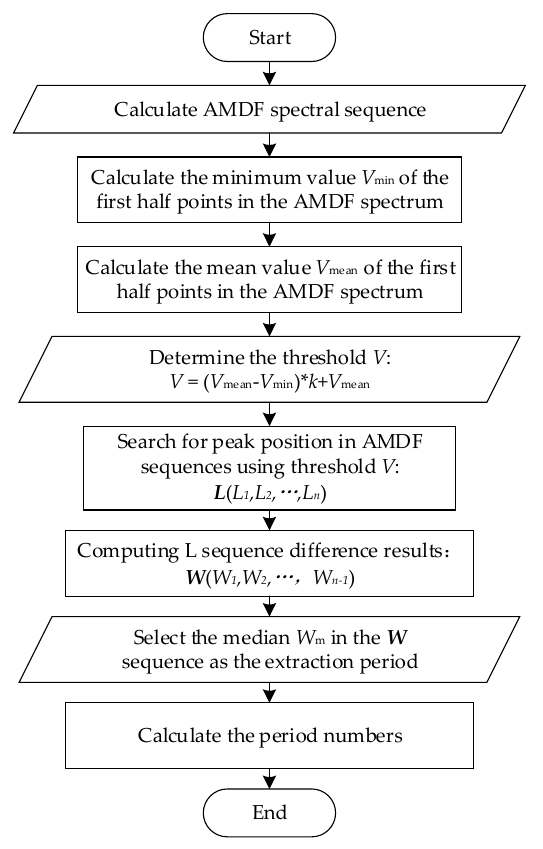
Figure 1. The flow chart of the peak extraction algorithm.